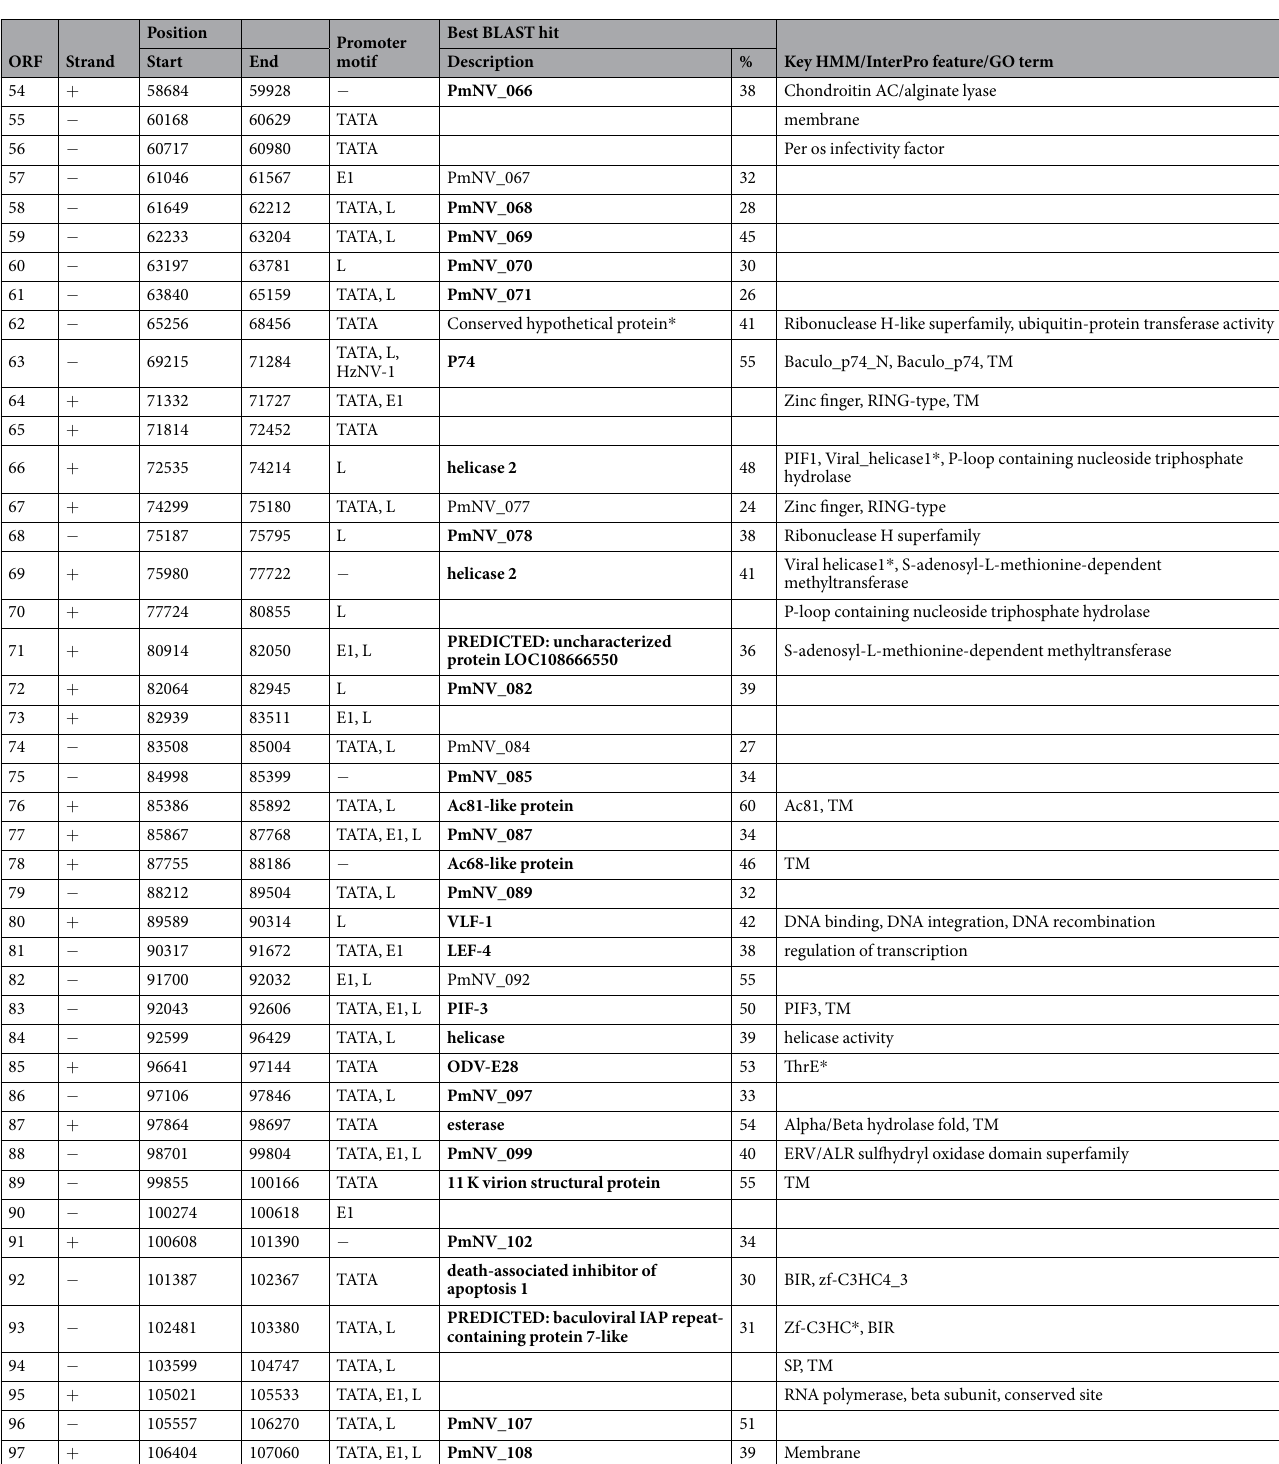
Table 3. Supported open reading frame annotations of the HgNV genome. BLAST annotations with an E-value equal or greater than 1 are not shown. Annotations with an E value > x10 10 are highlighted in bold. * Pfam annotations with an E-value less than 1. SP = signal peptide, TM = transmembrane